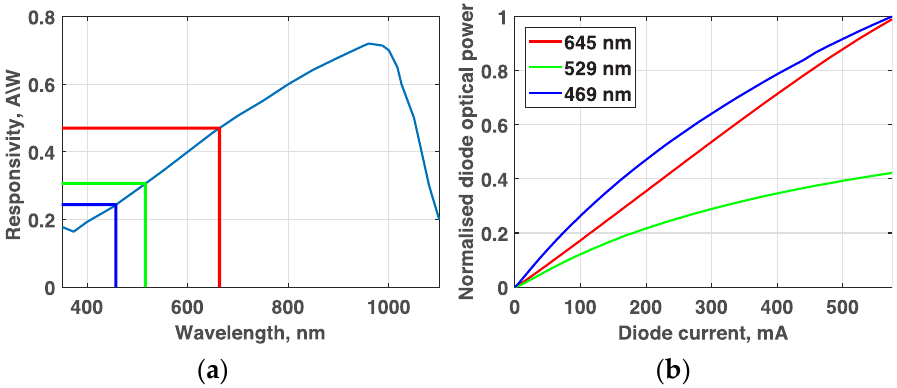
Figure 2. ( a ) A typical Si PD responsivity curve and ( b ) normalized E/O conversion of the RGB LED. Each of the CSI coefficients in this system is estimated by transmitting the PSs over a given time t and logged as the time-averaged amplitude. Note that the CSI coefficients are extracted using the double Gaussian curve fitting in MATLAB over a histogram of the received PS and by finding the amplitude between the maxima (Figure 3).